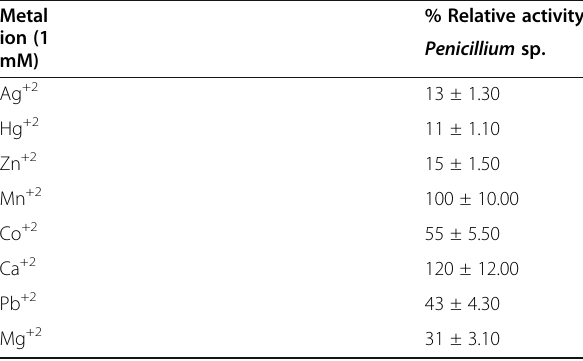
Table 3 Effect of metal ions on α -galactosidase